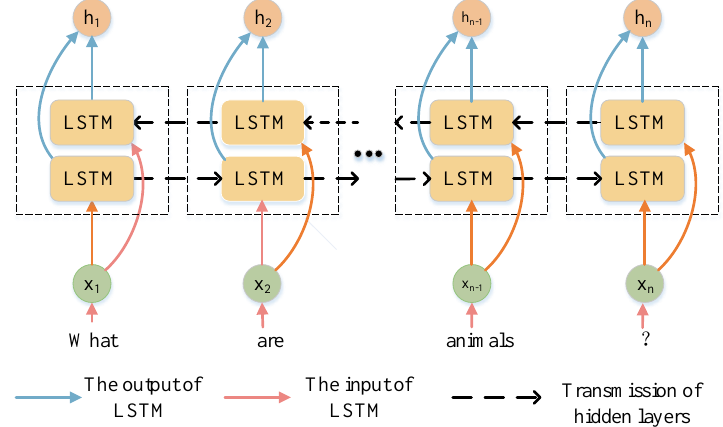
Figure 3. Structure of bidirectional long short term memory